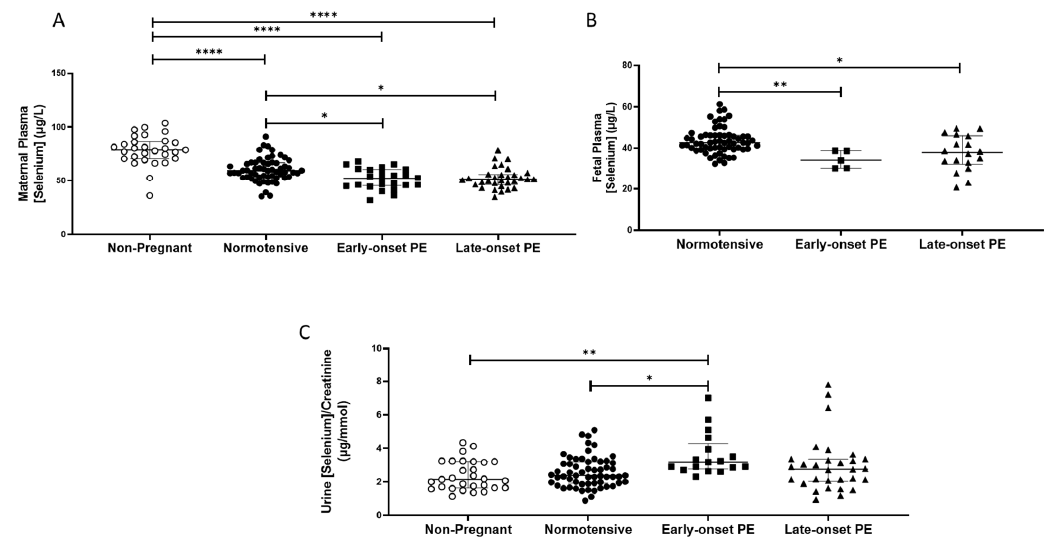
Figure 1. ( A ) Maternal plasma selenium concentrations in non-pregnant (n = 30) and normotensive pregnant women (n = 60) and those with early- (n = 24) and late-onset (n = 31) pre-eclampsia (PE); ( B ) umbilical cord venous (fetal) plasma selenium concentrations in normotensive pregnant women (n = 60) and those with early- (n = 5) and late-onset (n = 18) PE; ( C ) Urinary selenium/creatinine concentrations in non-pregnant (n = 28) and normotensive pregnant women (n = 60) and women with early- (n = 23) and late-onset (n = 31) PE. Data presented as median (IQR); * p < 0.05; ** p < 0.005; **** p < 0.0001.